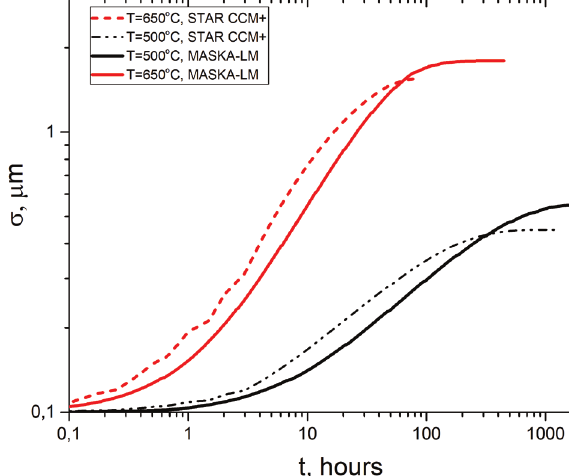
Figure 16. Results of film growth calculations performed within the framework of MASKA-LM, STAR-CCM+ for various tem - peratures and mass oxygen content 4*10 -7 kg/kg.